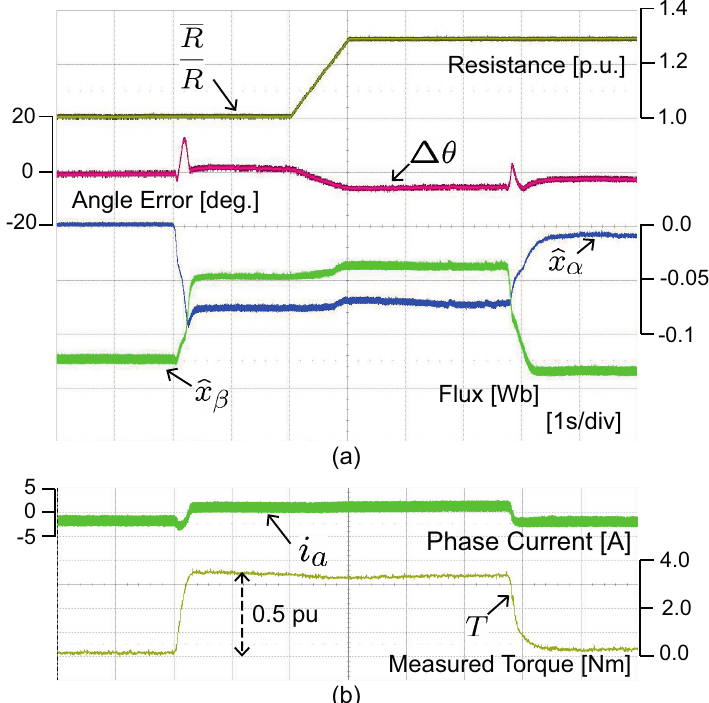
Figure 12. Zero speed control performance under 0.5 pu load when the resistor estimation error increased to 30%: ( a ) The erroneous resistance, estimated angle error, and estimated flux and ( b ) phase current and measured